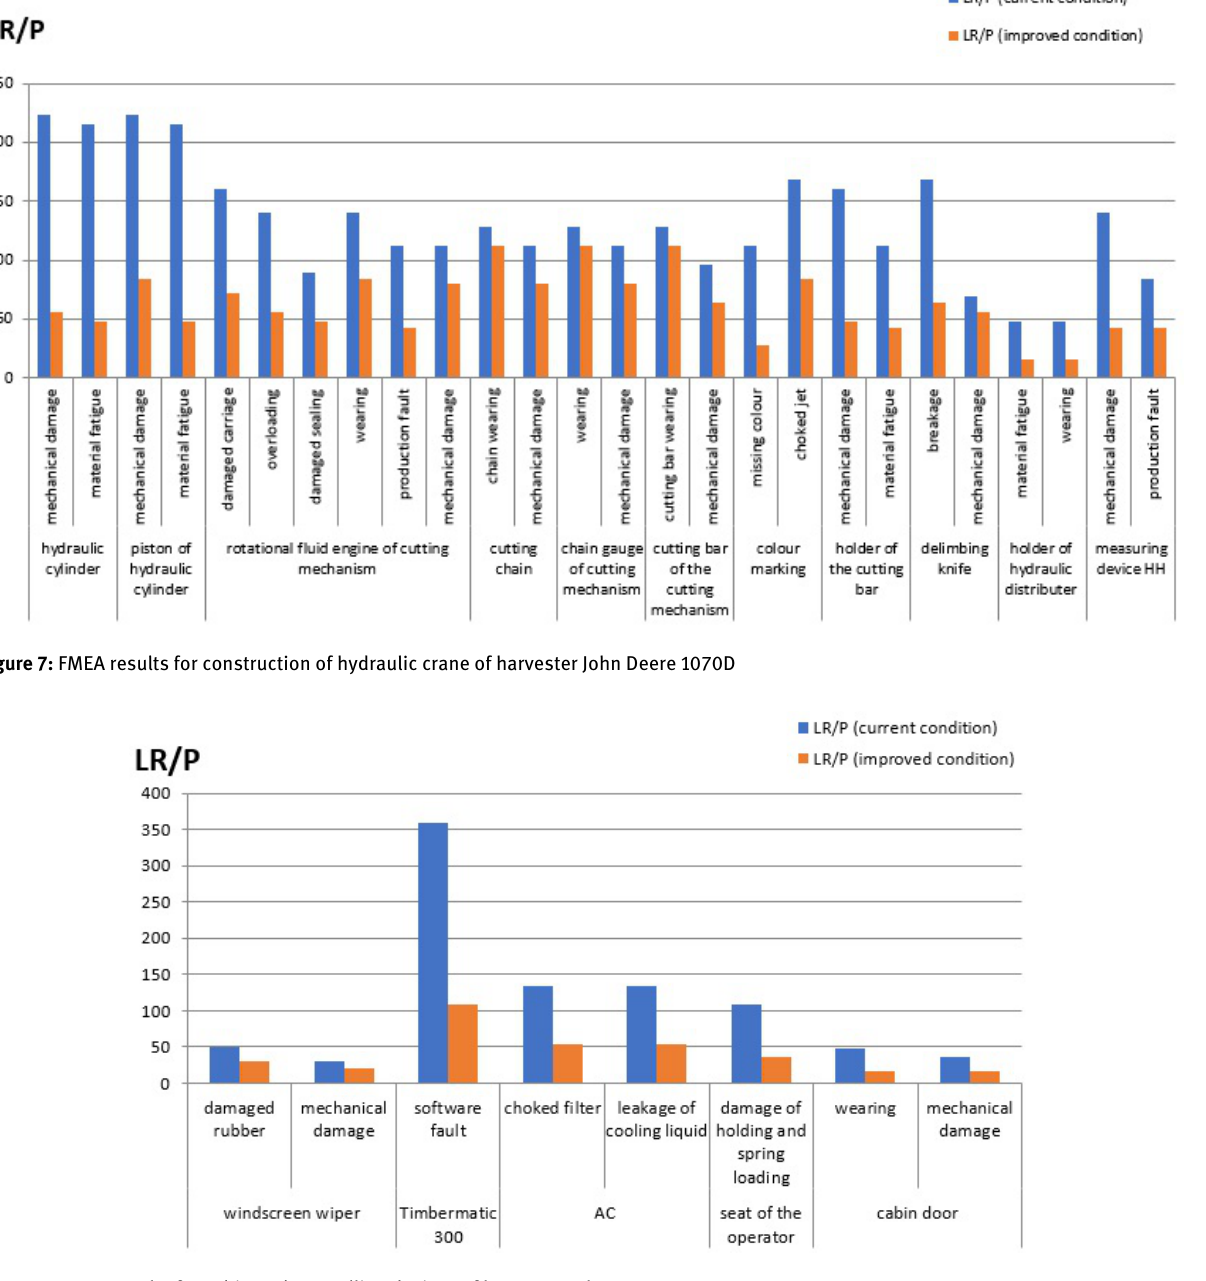
the machine. They are use as input data. There are mostly failures collected during research. The data are treated ac- cording to the system given by a